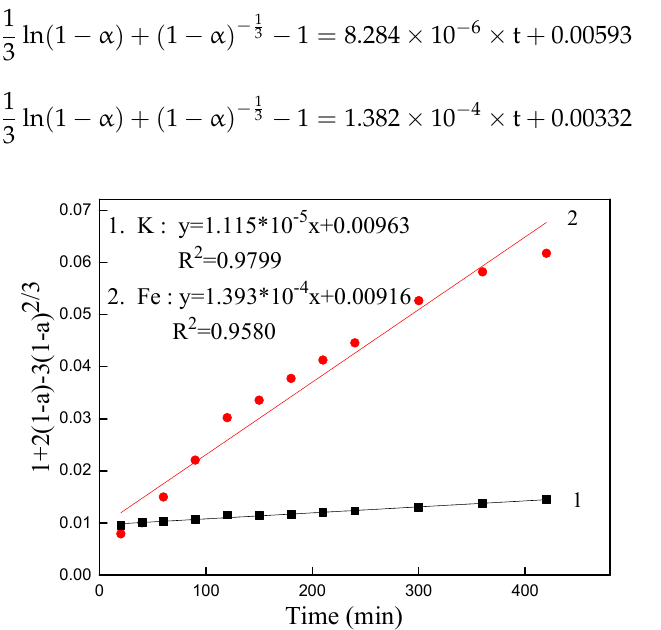
Figure 11. The diffusion kinetics model during removing process: 1 + 2(1 − α) − 3(1 − α) 2/3 versus reaction time.